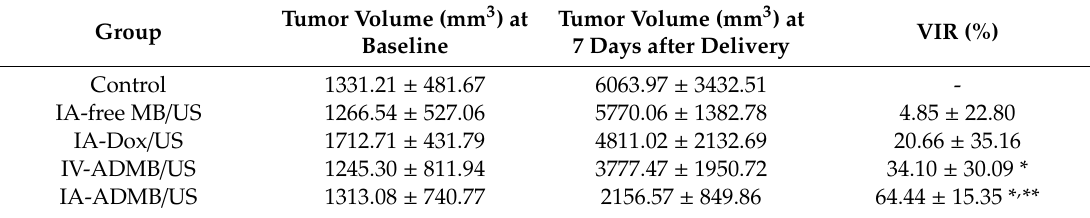
Figure 7. Quantitative volumetric image analysis at baseline and on day 7 after treatment, in IA ADMB / US, IV ADMB / US, IA Doxorubicin / US, IA free MB / US, and the untreated control groups. ( A ) Change in tumor volumes. ( B ) The Volume Inhibition Rate (VIR) of each group. ( C ) Percent change in ADC values across the experimental period among the groups. Each bar represents mean SD, * p < 0.05 versus IA Doxorubicin / US, IA free MB / US, and untreated control group. Table 1. The tumor volume and volume inhibition rate (VIR) of each group.